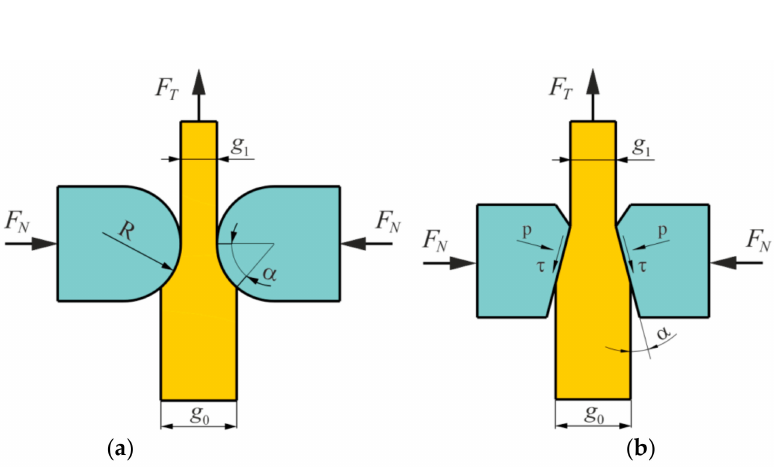
Figure 11. Illustrative diagram of the strip-reduction test carried out between ( a ) cylindrical dies ( b ) flat dies.